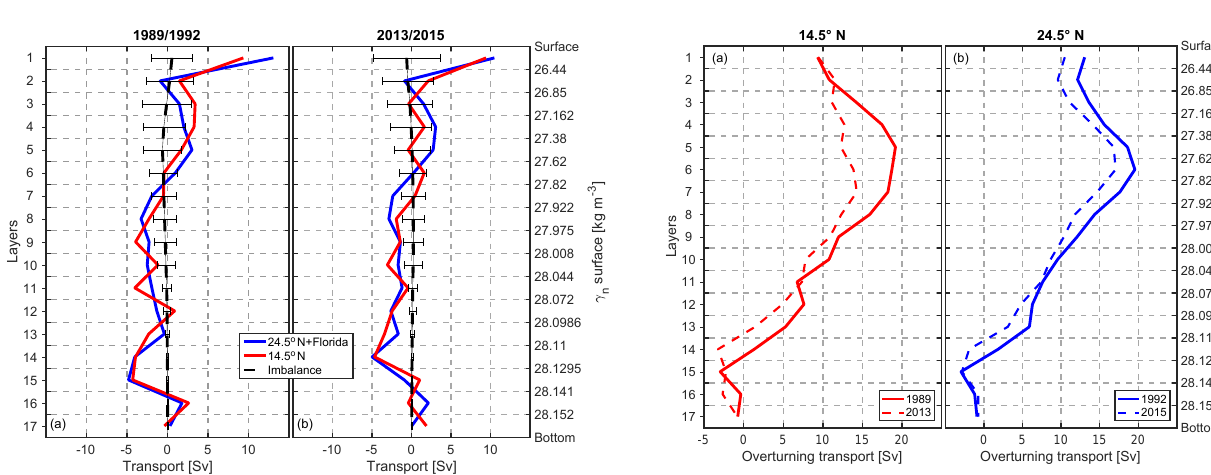
Figure 10. Final layer transports for the periods (a) 1989/1992 and (b) 2013/2015. The blue curves are the transports at the 24.5 ◦ N sec- tion including the Florida Current transport; the red curves mark the transport at the 14.5 ◦ N section, and the black dashed lines are the final imbalance of the layers with error bars. Note that the imbal- ance in each layer is calculated after taking into account the merid- ional and dianeutral transports across the side boundaries and verti- cal boundaries of that layer.